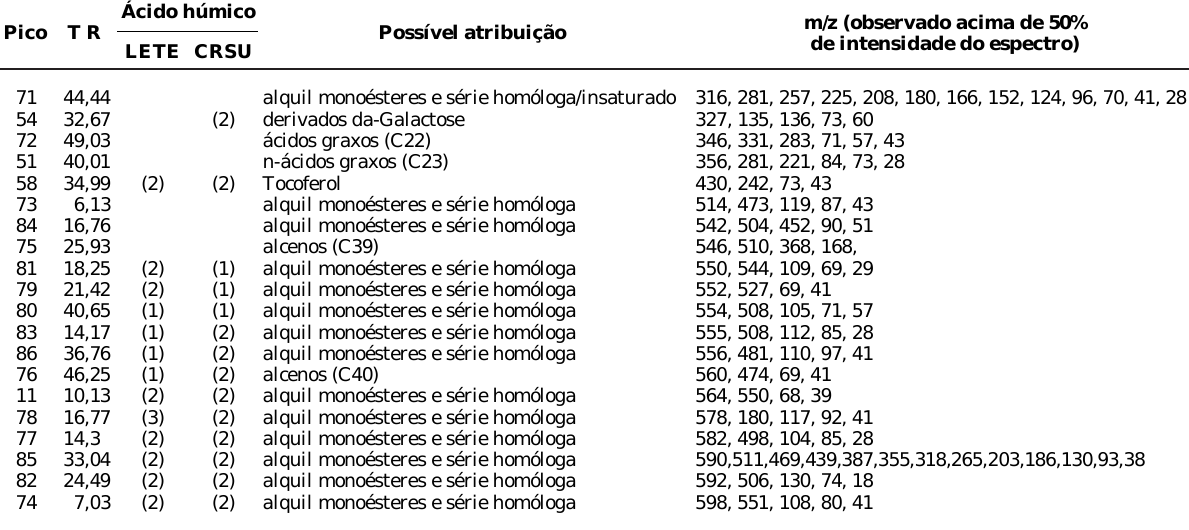
598, 551, 108, 80, 41